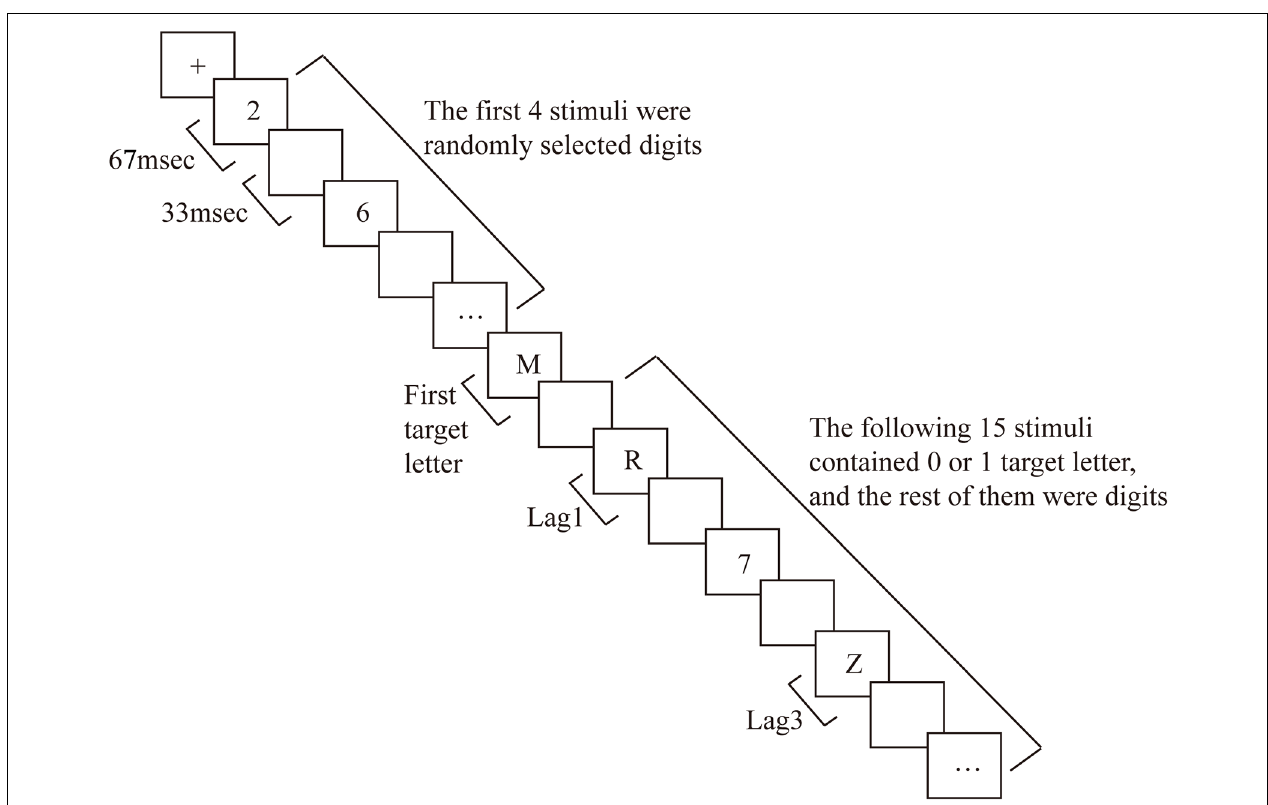
FIGURE 1 | The attentional blink procedure used in this